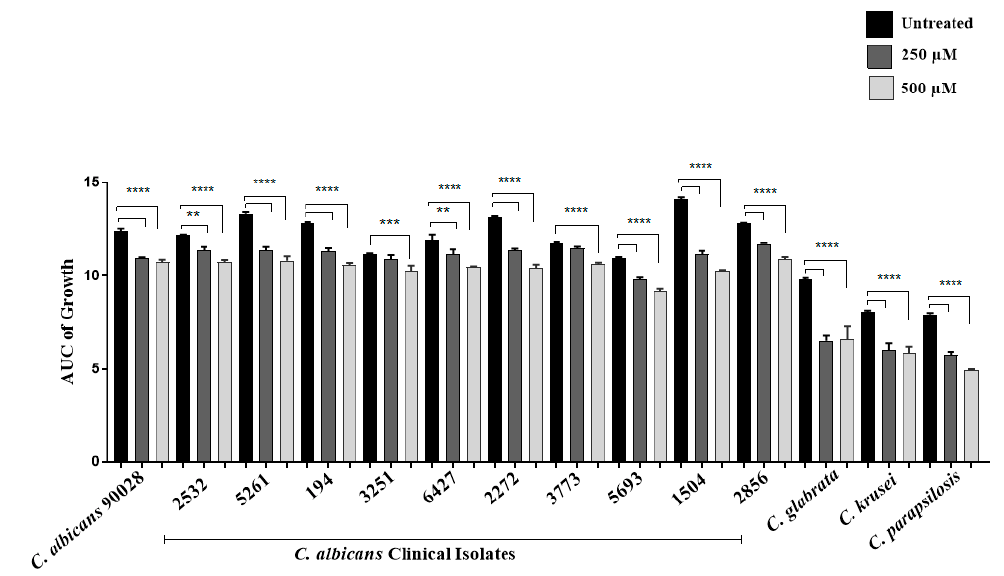
Figure 3. Limonene antifungal activity in ATCC strains of C. albicans , Candida krusei, Candida glabrata, Candida parapsilosis , and 10 C. albicans clinical isolates. Culture growth was monitored hourly, through OD 600 readings. Measurements were performed in triplicate, and the graph shows the areas under the curve and their respective standard deviations. ** p < 0.01, *** p < 0.001, and **** p < 0.0001 compared with the control group (untreated; ANOVA with post-hoc Tukey’s test).